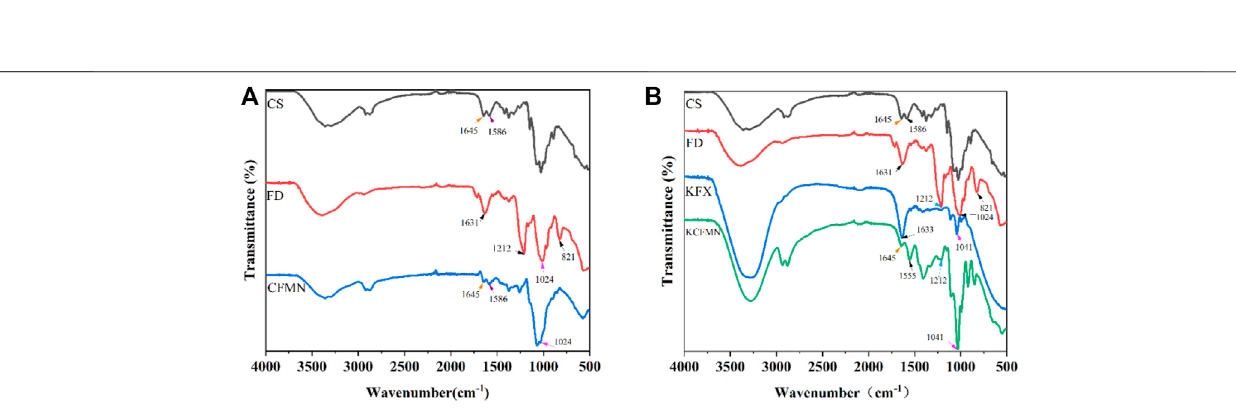
Frontiers in Chemistry |